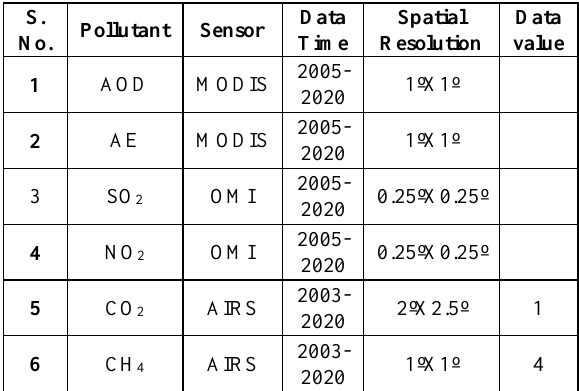
Table 2: Details of spatial and temporal resolution of data downloaded from NASA